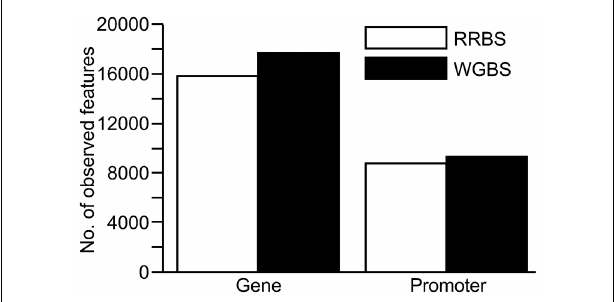
FIGURE 4 | Comparison of coverage at genomic features (genes and promoter regions) from sequence data generated from a reduced representation bisulfite sequencing (RRBS) library versus a whole genome bisulfite sequencing (WGBS) library. For inclusion, the genomic feature had to contain at least three CpG sites with ≥ 10x coverage. Promoter regions were defined as 2 kb upstream of the transcription start site.